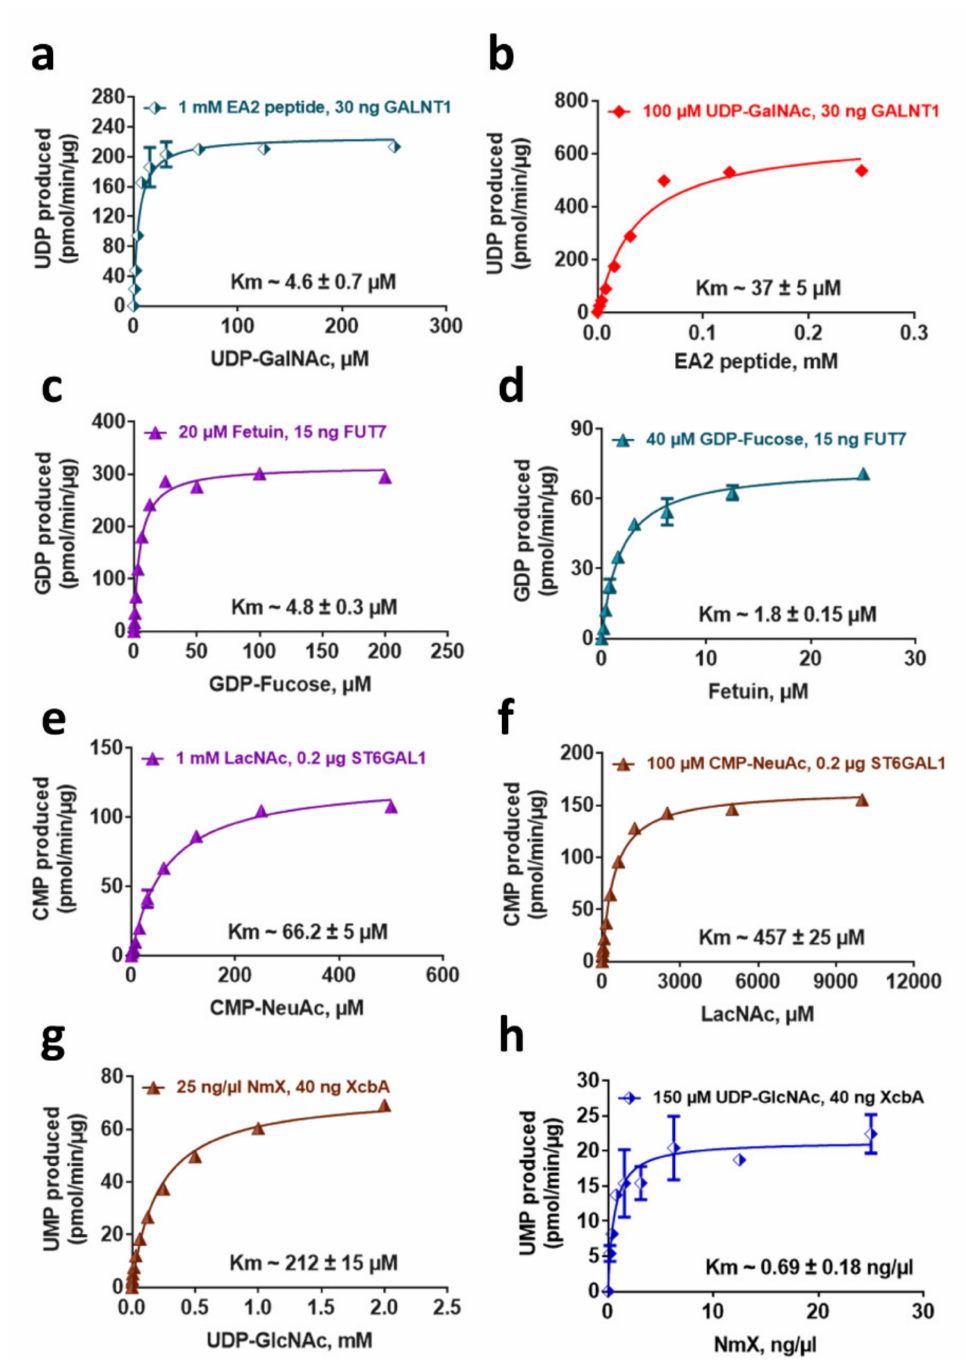
Figure 6. Substrate kinetic analysis of glycosyltransferase reactions using bioluminescent nucleotide assays. ( a , c , e , g ) Km determination of the four nucleotide sugars in GalNAc, Fucosyl, Sialyl, and phosphoGlcNAc—transferase reactions using the indicated concentrations of the corresponding acceptor substrates. ( b , d , f , h ) Km determination of the different acceptor substrates in GalNAc, Fucosyl, Sialyl, and phosphoGlcNAc—transferase reactions using the indicated concentrations of the corresponding sugar donor substrates. The reactions were performed in duplicates, and the results shown are means ± standard deviations. Km values were extracted from the data after fitting to the Michaelis–Menten equation using the non-linear regression fit in GraphPad Prism ® , version